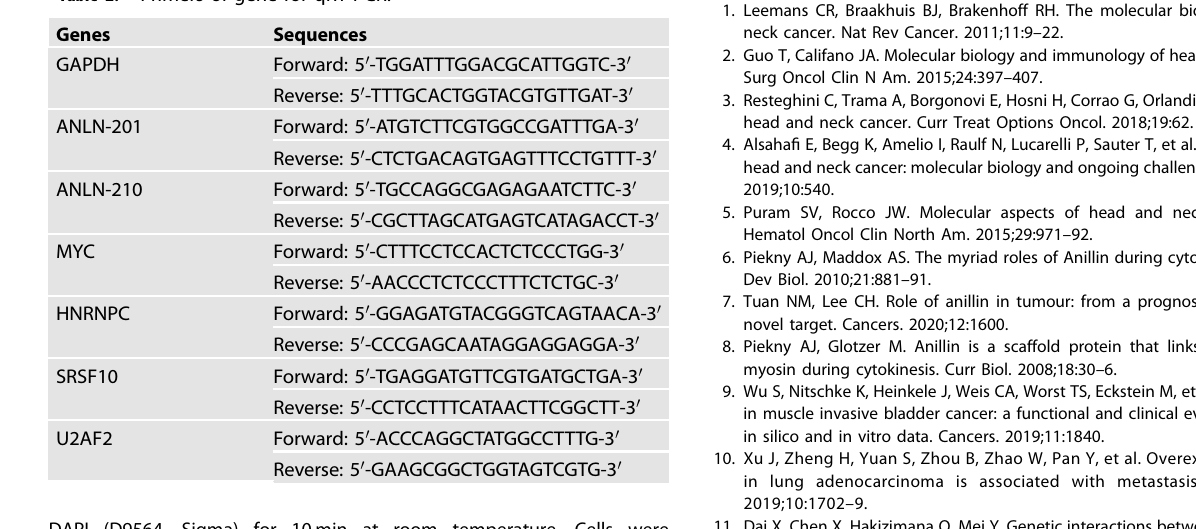
Table 2. Primers of gene for